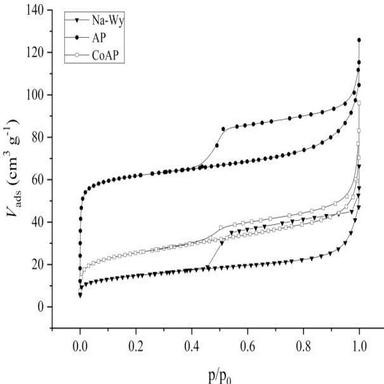
Low temperature N2 adsorption-desorption isotherms.